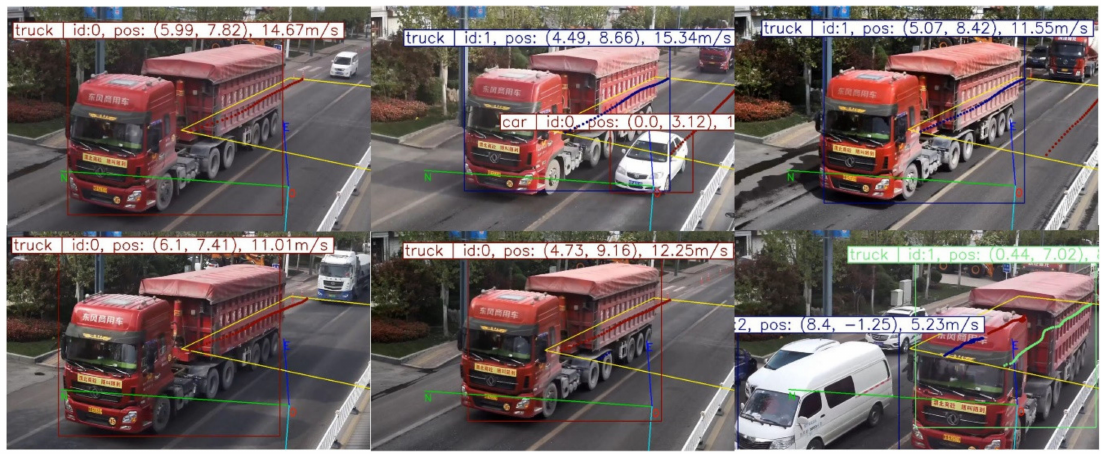
Figure 16. Verification experiments truck driving state information extraction effect diagram.